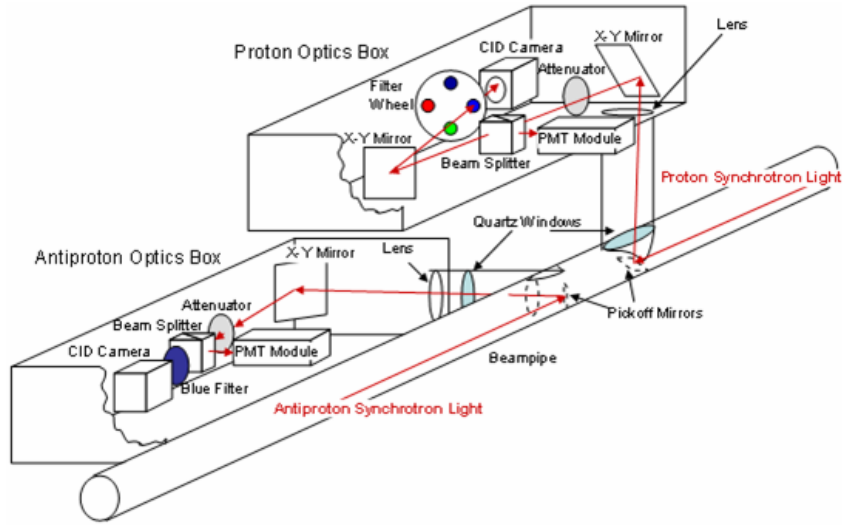
FIG. 8. (Color) Diagram of optical collection system. There is one light box for the protons, and one for the antiprotons.